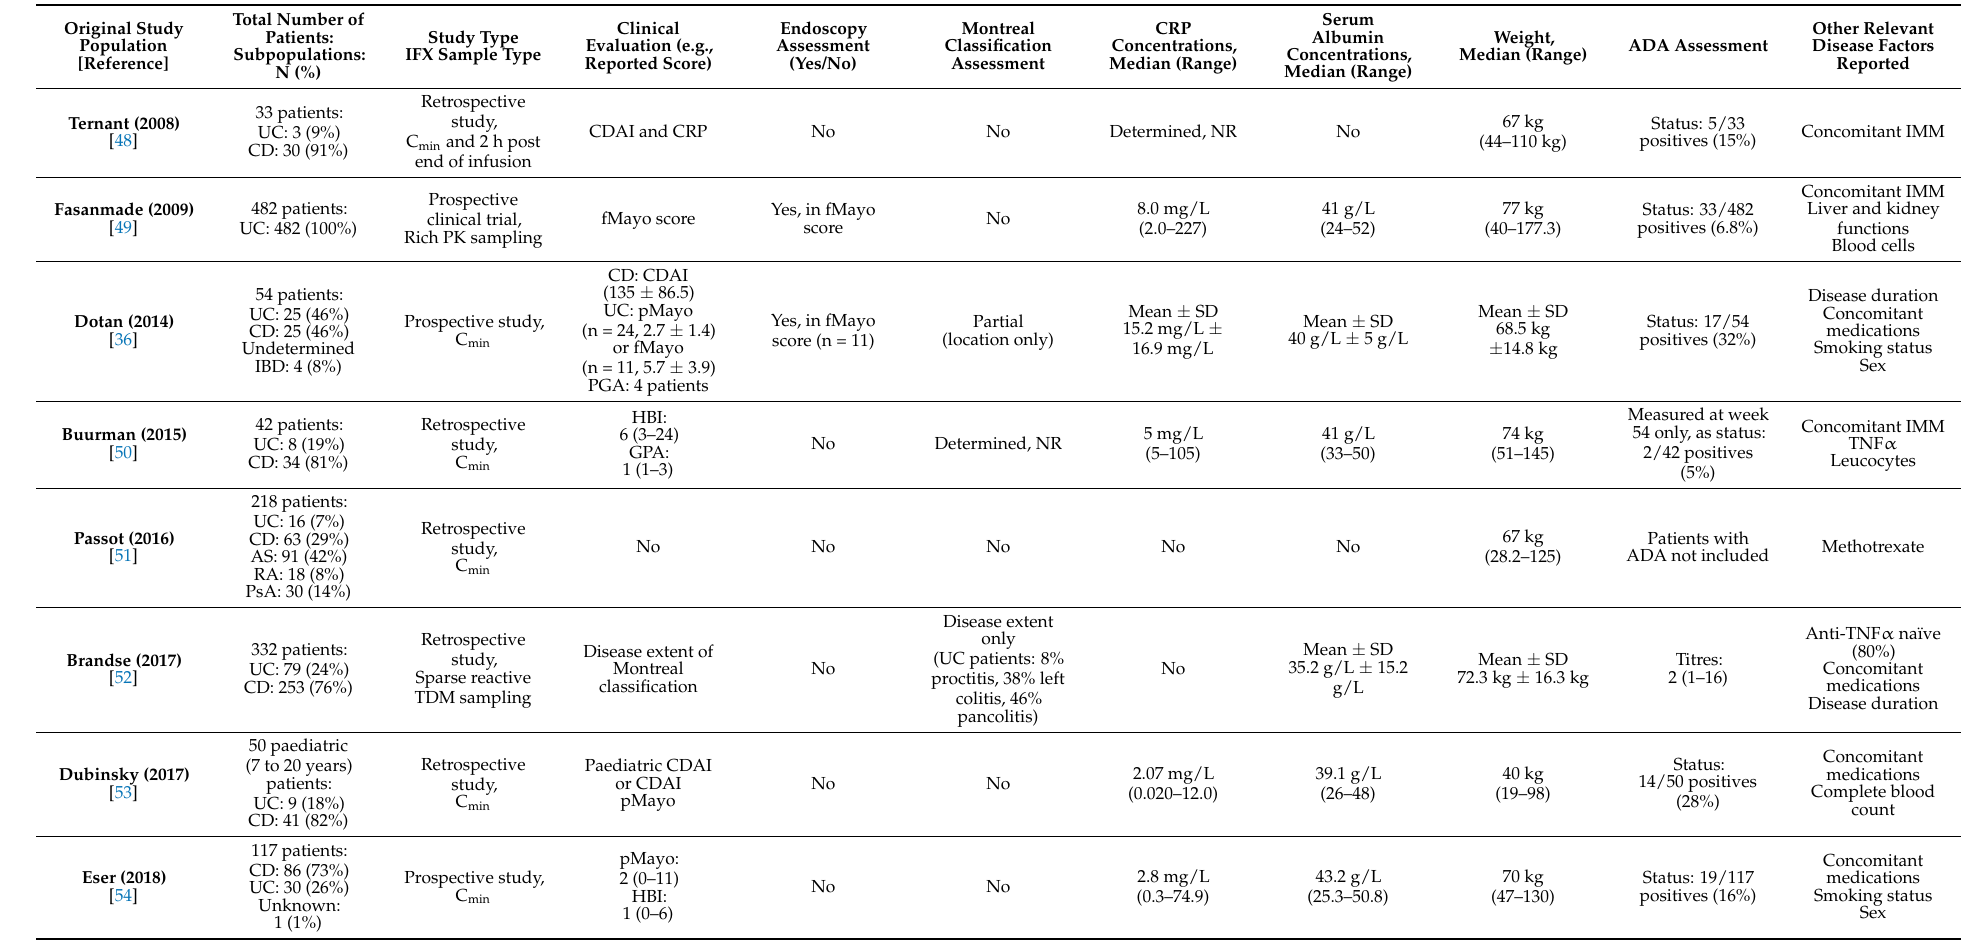
Table 1. Patient populations included in the selected articles and clinically relevant